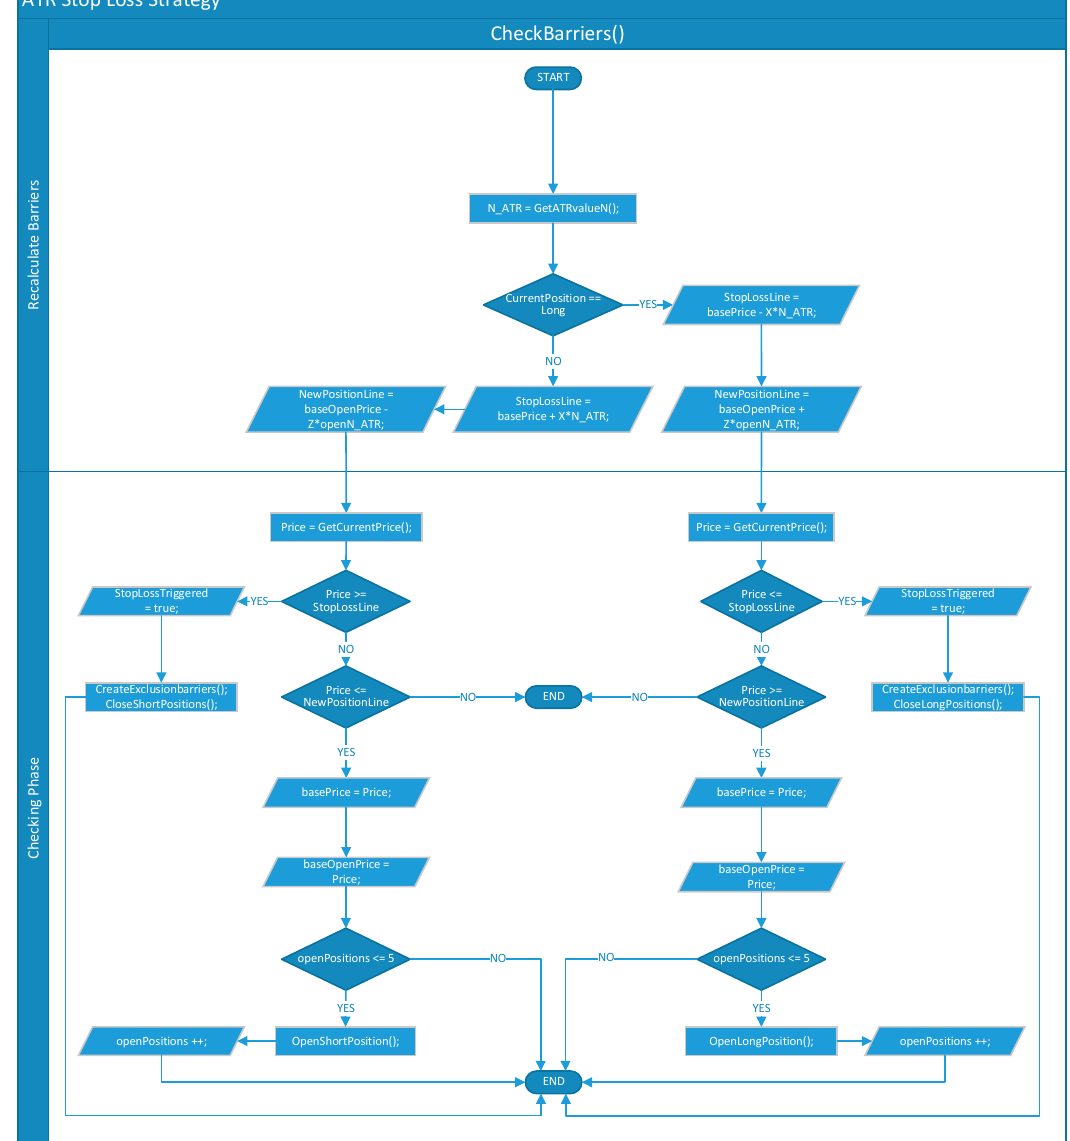
Figure 5. Recalculation and checking point of the stop loss and open new position barriers in order to close or open a position if needed.